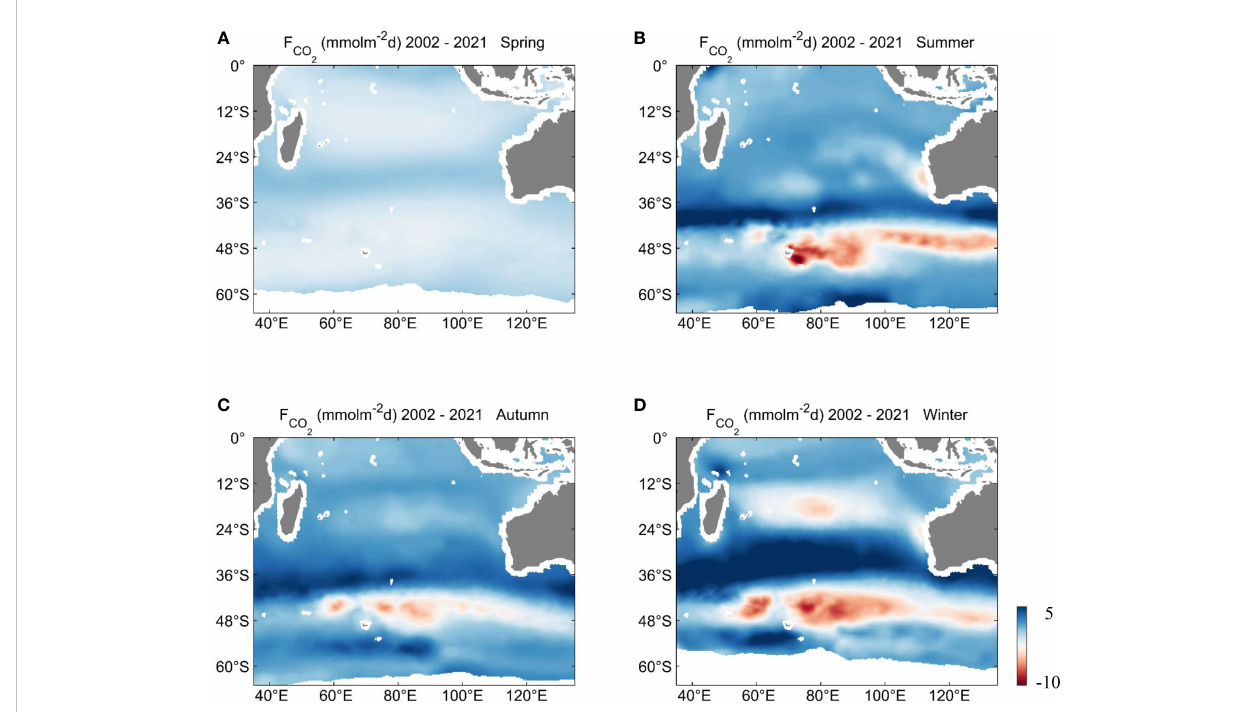
FIGURE 7 Differences for the seasonal and spatial distributions between with and without windseas impact. (A) Spring, (B) Summer, (C) Autumn, (D) Winter.